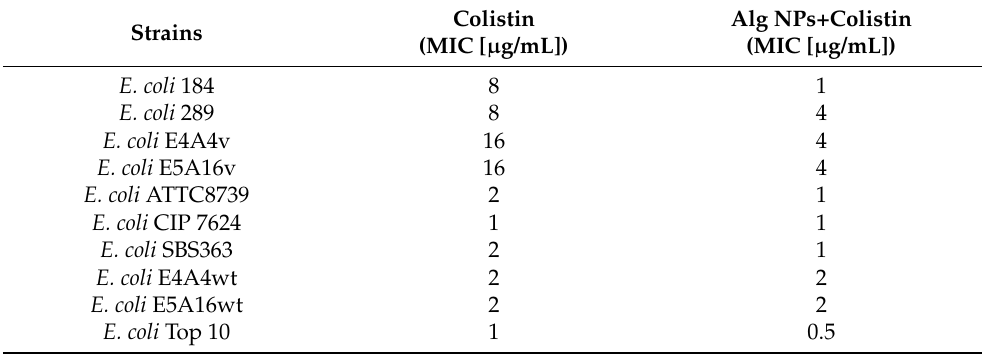
Table 1. MIC of colistin alone and in combination with Alg NPs against different E. coli strains. Colistin Alg NPs+Colistin Strains (MIC [ µ g/mL]) (MIC [ µ g/mL]) E. coli 184 8 1 E. coli 289 8 4 E. coli E4A4v 16 4 16 4